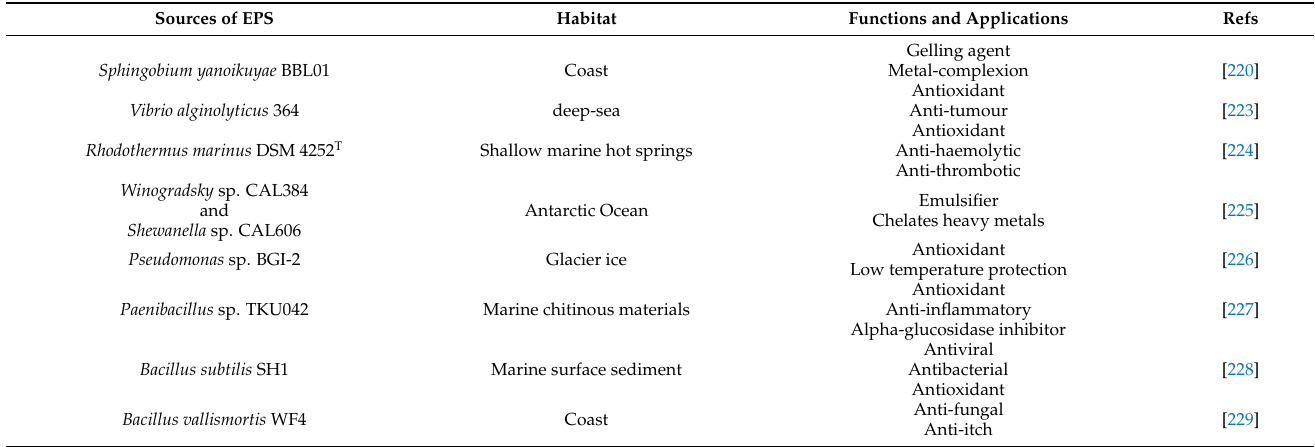
Table 5. Sources and characteristics of representative marine